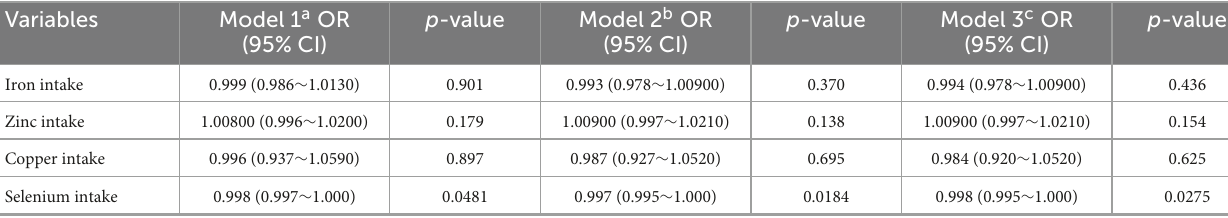
TABLE 2 Association between intake of iron, zinc, copper, selenium and